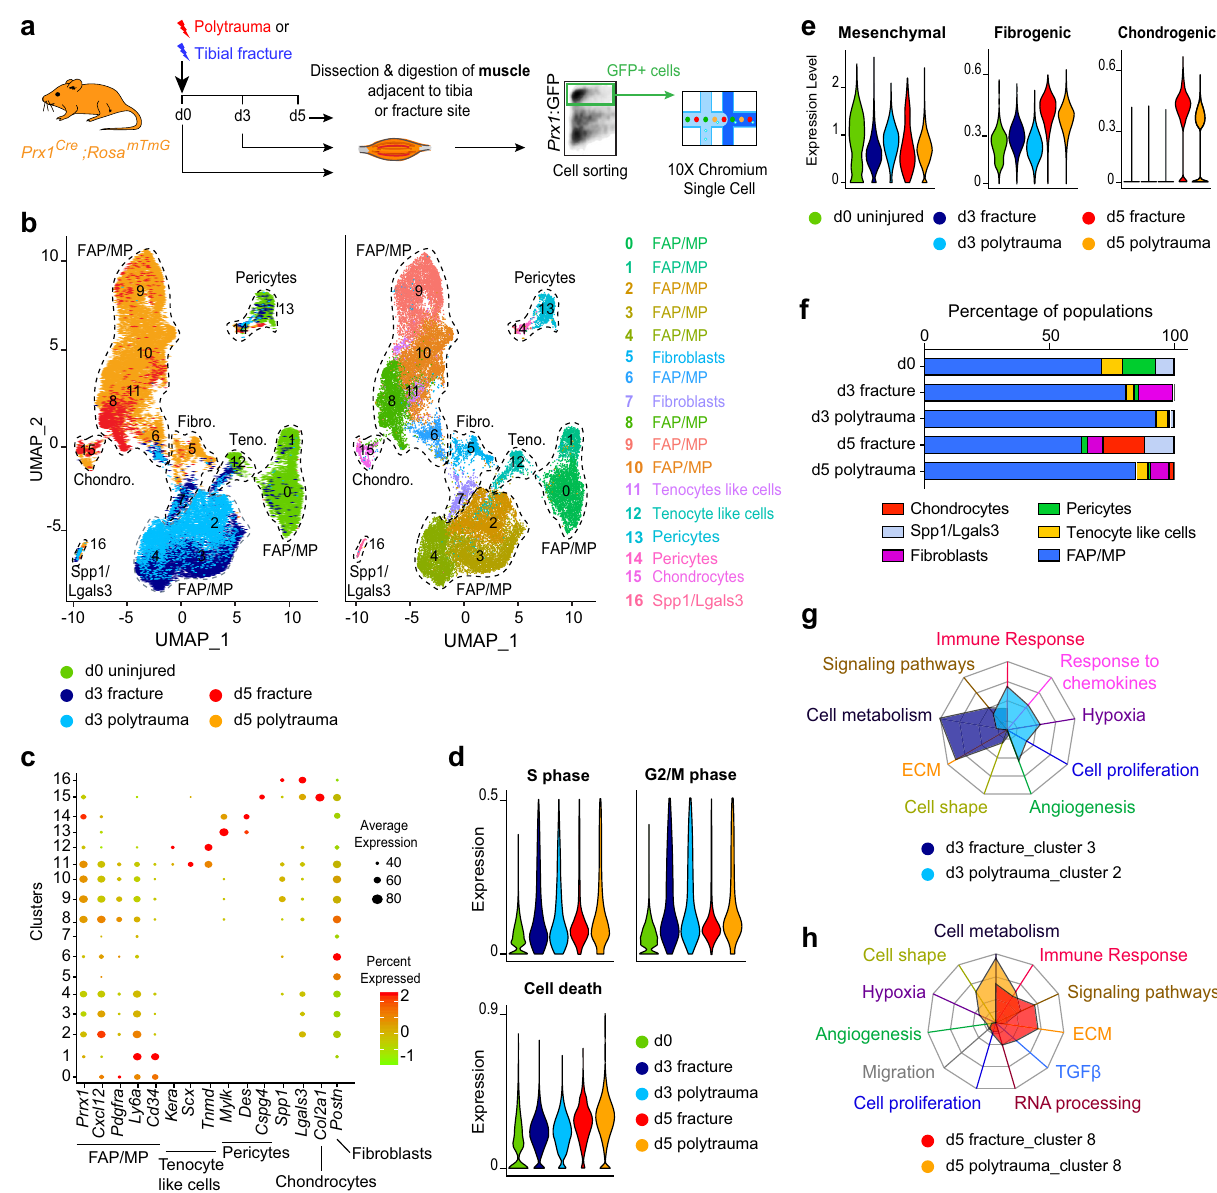
cellsPericytes ChondrocytesFibroblasts FAP/MP Tenocyte like Fig. 5 Single-cell analyses of skeletal muscle mesenchymal progenitors uncover impairment of initial fi brotic response in polytrauma. a Experimental design of scRNAseq experiment. Prx1-derived skeletal muscle cells were isolated at d0, d3, and d5 post-non-stabilized fracture or post-polytrauma and sorted based on GFP-expression prior to scRNAseq. b UMAP projection of color-coded sample (left) and clustering (right) of integrated analysis of d0, d3, and d5 post-fracture and post-polytrauma samples. Sub-populations are delimited by a black dotted line. Sample and cluster identities are indicated below and on the right, respectively. c Dotplot of indicated gene expression identifying FAP/MP, tenocyte-like cell, pericyte, Spp1/Lgals3, chondrocyte, and fi broblast populations. d Expression of S and G2/M cell cycle phases and cell death scores per sample. e Pseudobulk expression of mesenchymal, fi brogenic and chondrogenic lineage score in d0, d3, and d5 post-fracture and post-polytrauma samples. f Percentage of each cell population per sample. g Radar chart of enriched Gene Ontology functions in cluster 3 corresponding to d3 post non-facture and cluster 2 corresponding to d3 post-polytrauma. h Radar chart of enriched Gene Ontology functions in d5 post-fracture versus d5 post-polytrauma in cluster 8. Teno. tenocyte like cells, Fibro. fi broblasts, Chondro.